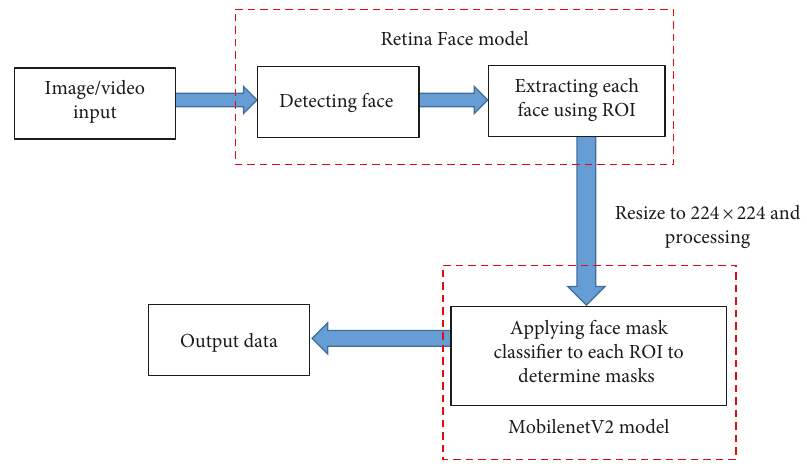
Figure 10: Diagram of the proposed